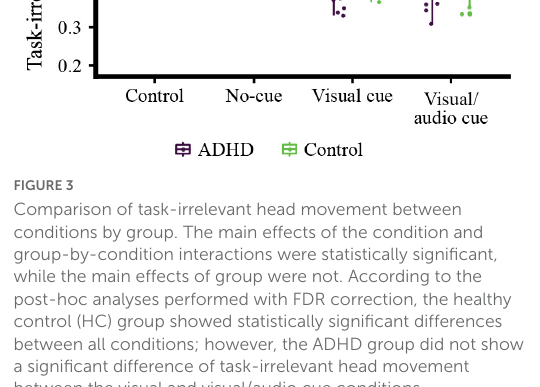
Table 4 . Most interactions had anecdotal evidence for either the null or the alternative hypothesis, indicating that results are largely